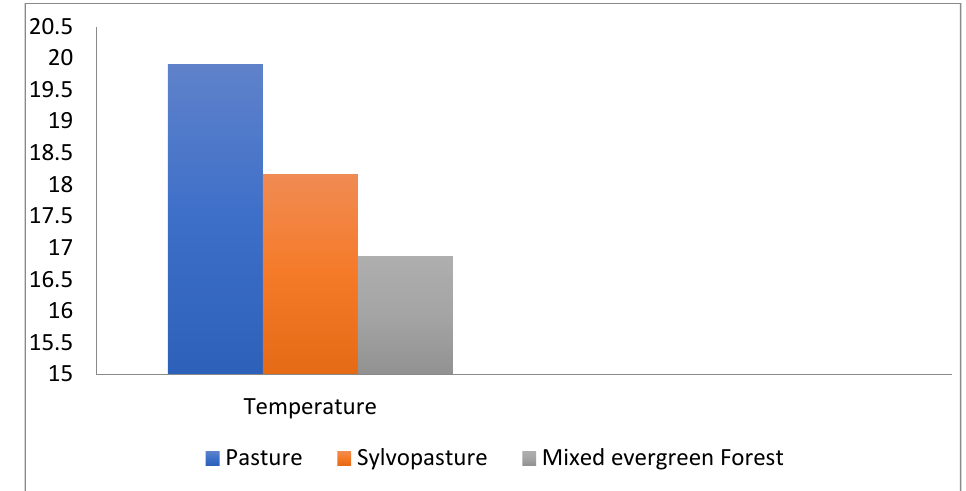
Figure 3. Declining of soil temperature from Pa to SP to MEF.